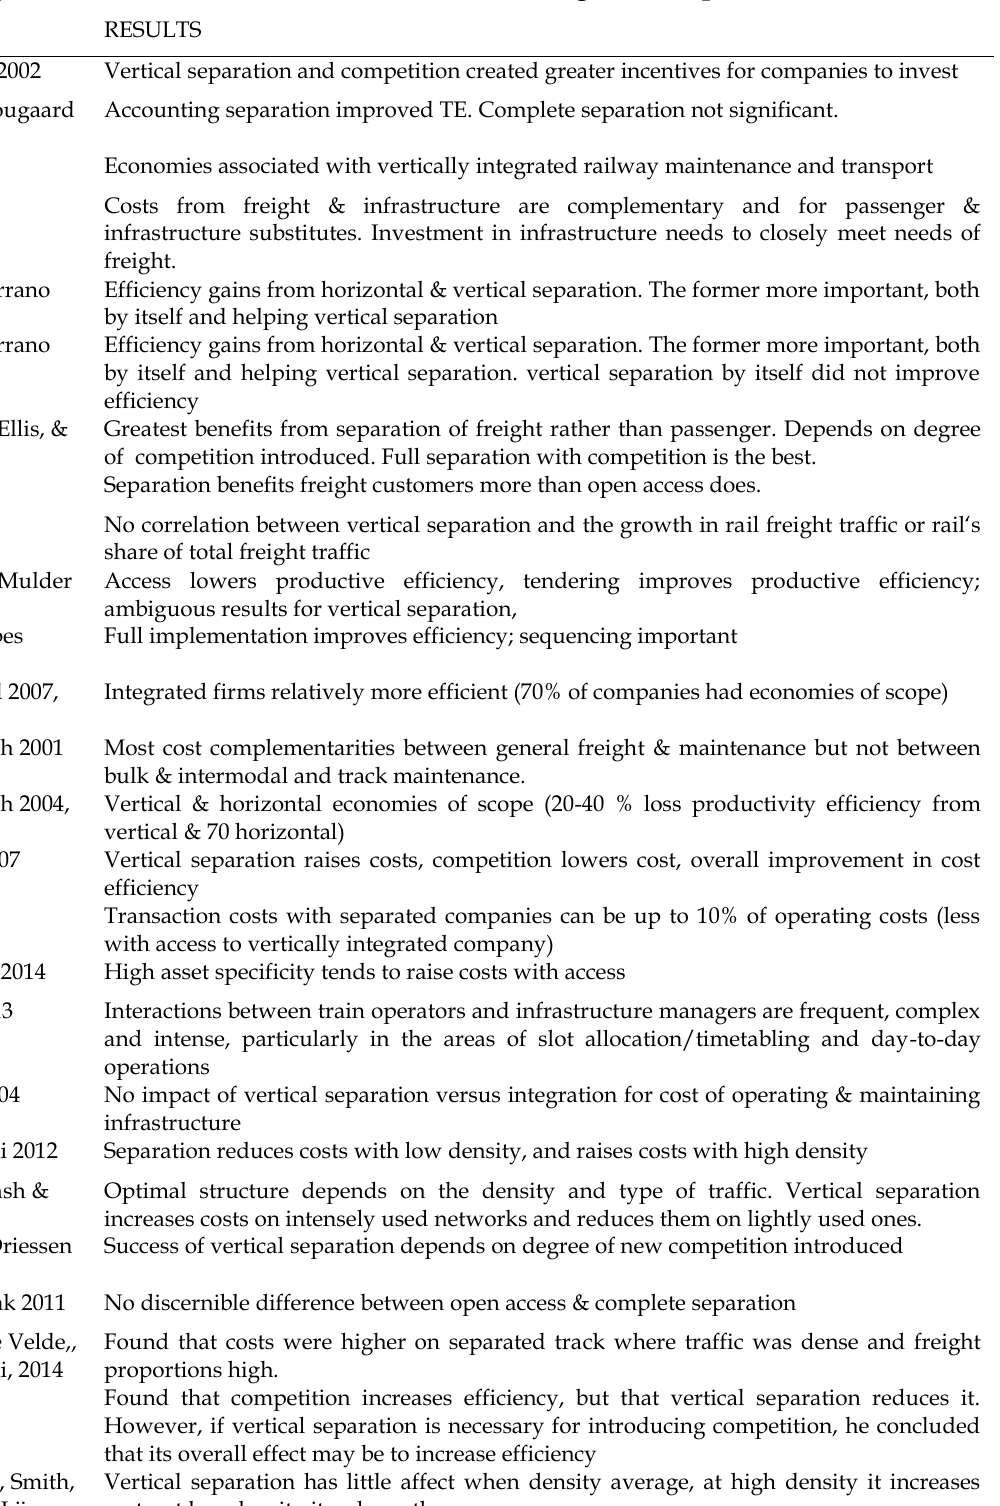
Table 1. Summary of the results of the studies on rail vertical integration